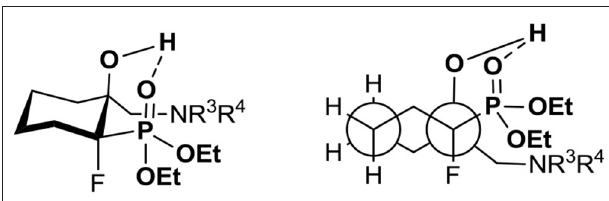
FIGURE 4 | The proposed predominant conformation of γ -amino- β -hydroxyphosphonates 21–24 .